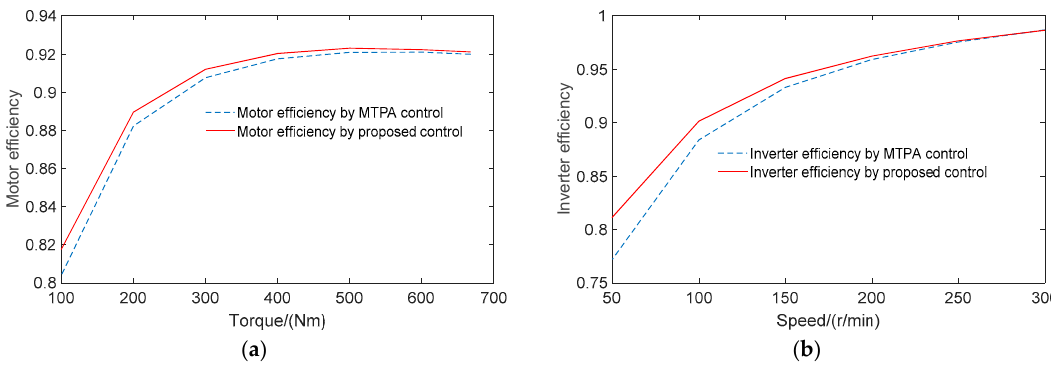
Figure 13. Efficiency of the SiC-MOSFETs-based PMSM drive system by the traditional MTPA control and proposed system efficiency improvement control. ( a ) Motor efficiency at rated speed; ( b ) inverter efficiency at rated torque.